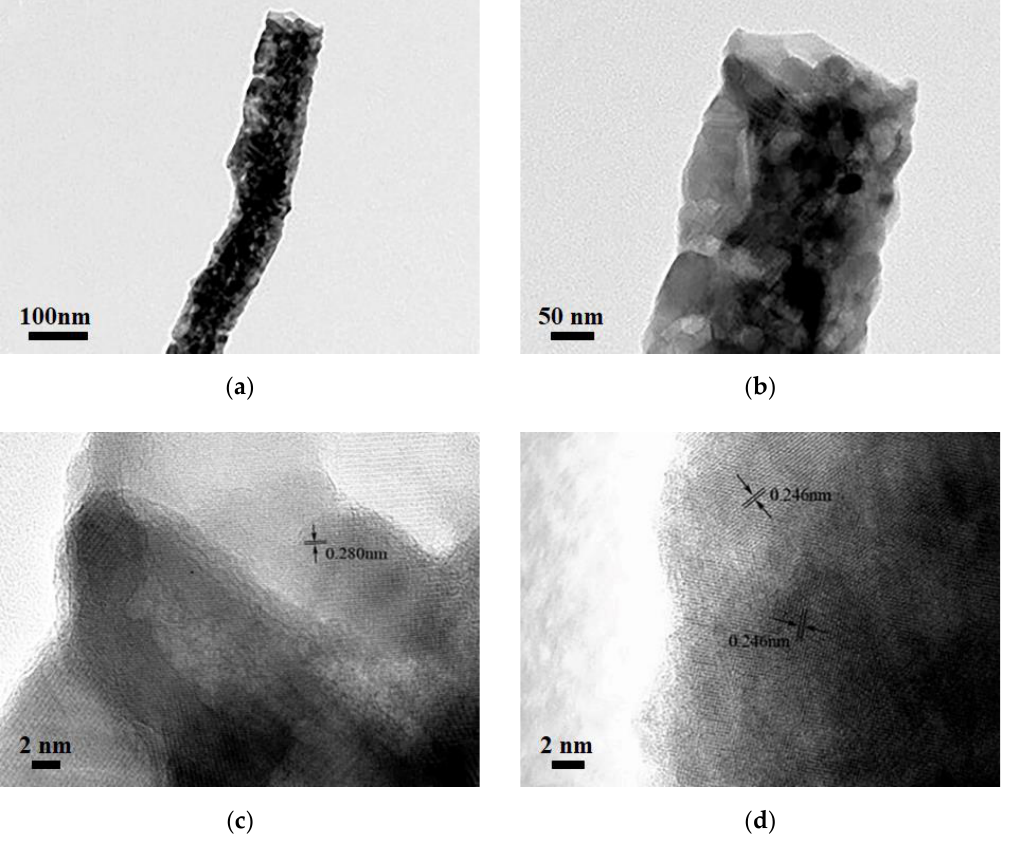
Figure 3. ( a , b ) TEM and ( c , d ) HRTEM images of S 850